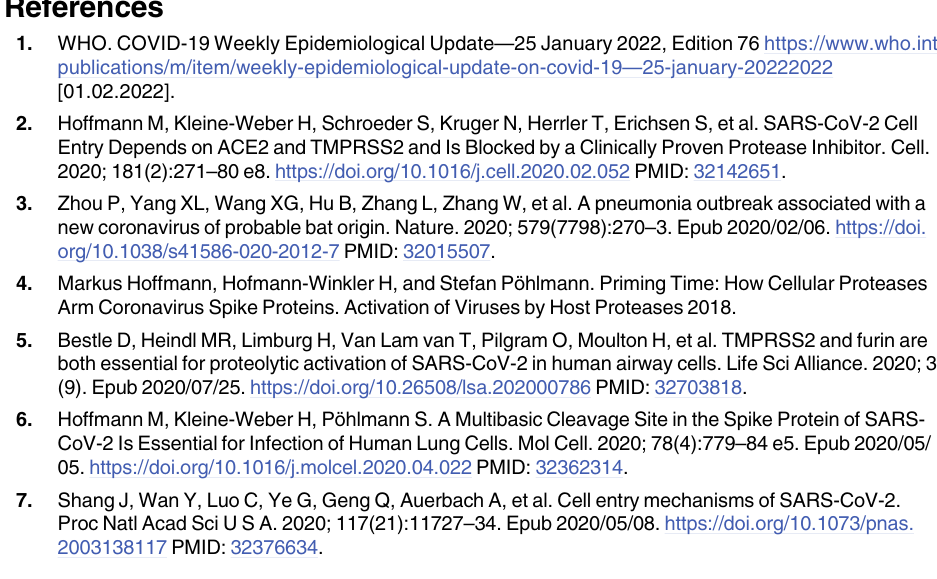
S1 Fig. Ribbon models of the extended S1/S2 loop containing the mutations under study. The indicated mutations in the extended S1/S2 loop were introduced using UCSF Chimera (version 1.14). Colour code: blue = residues 668–671 of the S1 subunit that are located upstream of the S1/S2 loop; orange = extended S1/S2 loop (residues 672–691); red = multibasic S1/S2 cleavage site (682-RRAR-685) within the extended S1/S2 loop; grey = residues 692–695 of the S2 subunit that are located downstream of the S1/S2 loop. (TIF) S2 Fig. Unprocessed images of immunoblots shown in Figs 1C and 4B.